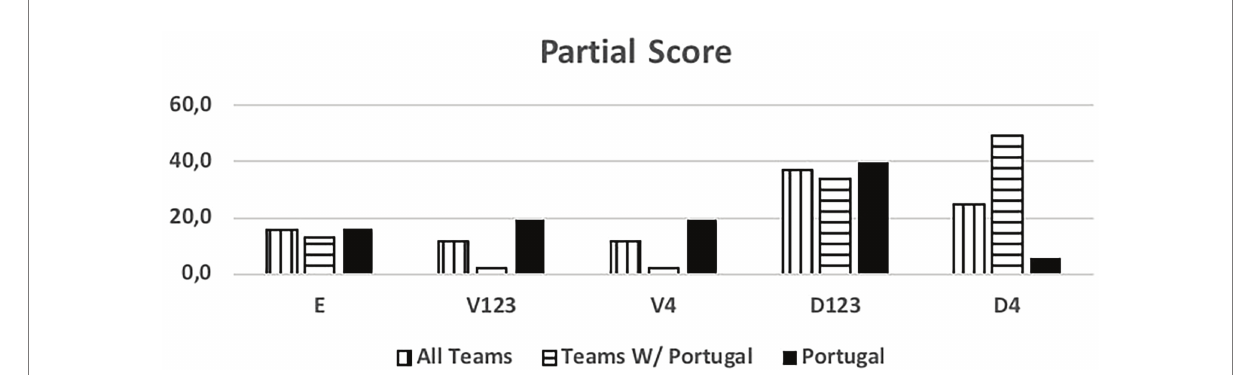
FIGURE 2 Partial score. E, draw; V123, winning by one, two or three goals; V4, winning by four or more goals; D123, defeat by one, two or three goals; D4, defeat by four or more goals.